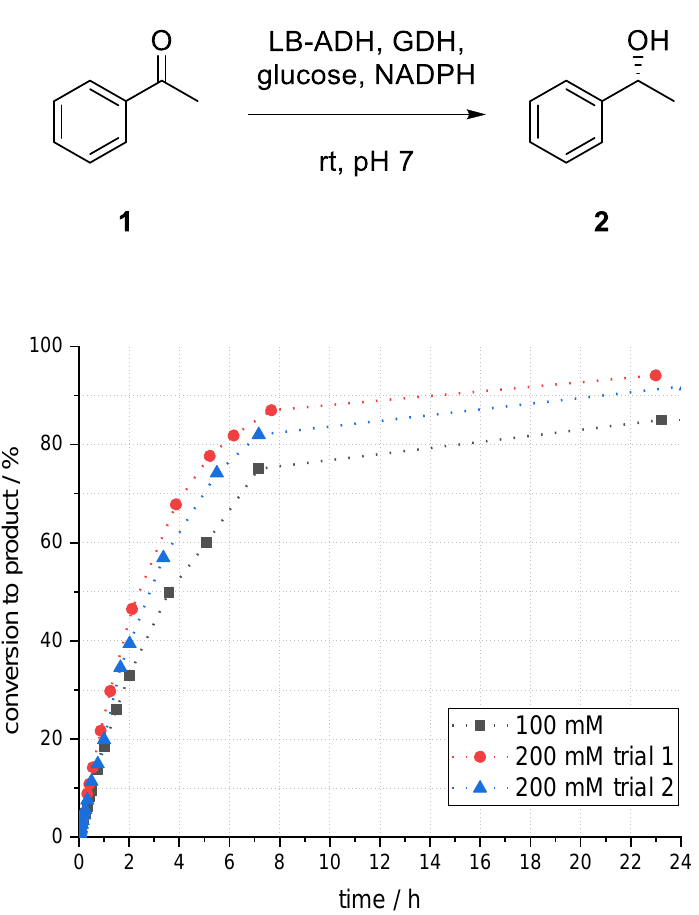
Figure 9. Influence of PPB bu ff er concentration on the conversion to phenylethanol ( R )- 2 in an enzymatic reduction of acetophenone ( 1 ) using ADH in superabsorber-immobilized aqueous phase. Figure 9. Influence of PPB buffer concentration on the conversion to phenylethanol ( R )- 2 in an 3.6. Studies on the Influence of the Superabsorber Particle Size on the Acetophenone Reduction with a enzymatic reduction of acetophenone ( 1 ) using ADH in superabsorber-immobilized aqueous phase. Superabsorber-Immobilized Recombinant Alcohol Dehydrogenase from Lactobacillus brevis Another process parameter of potential relevance was the interface area of organic and